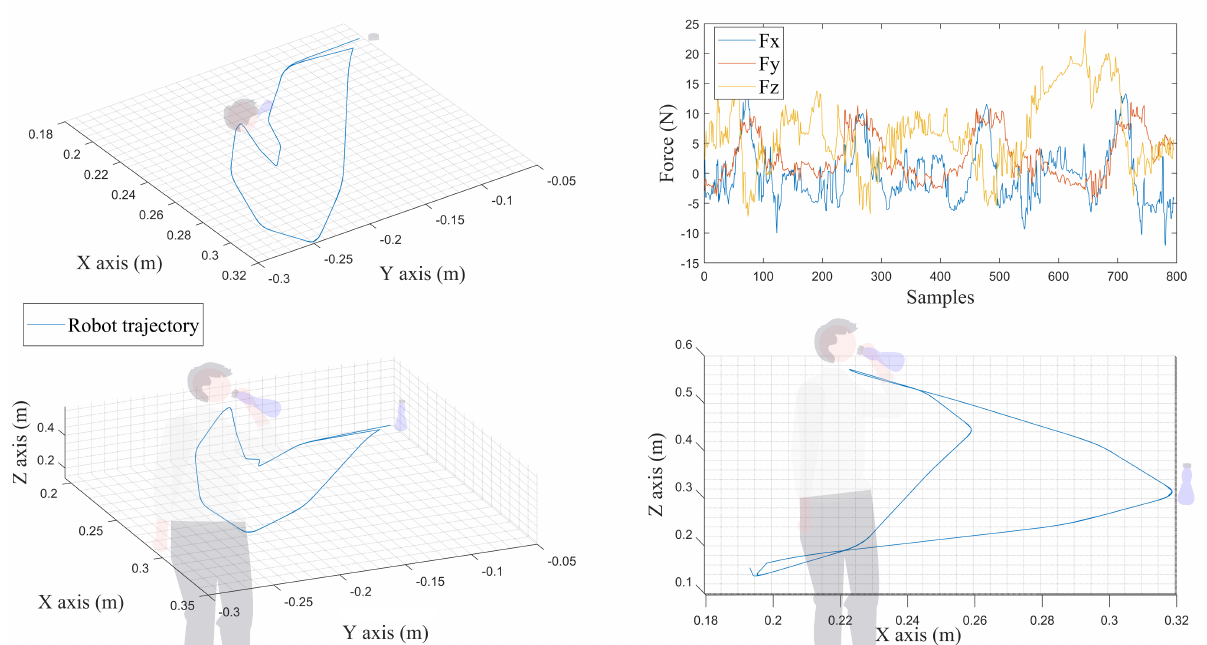
Figure 15. Experimental test for an ADL based rehabilitation—drinking